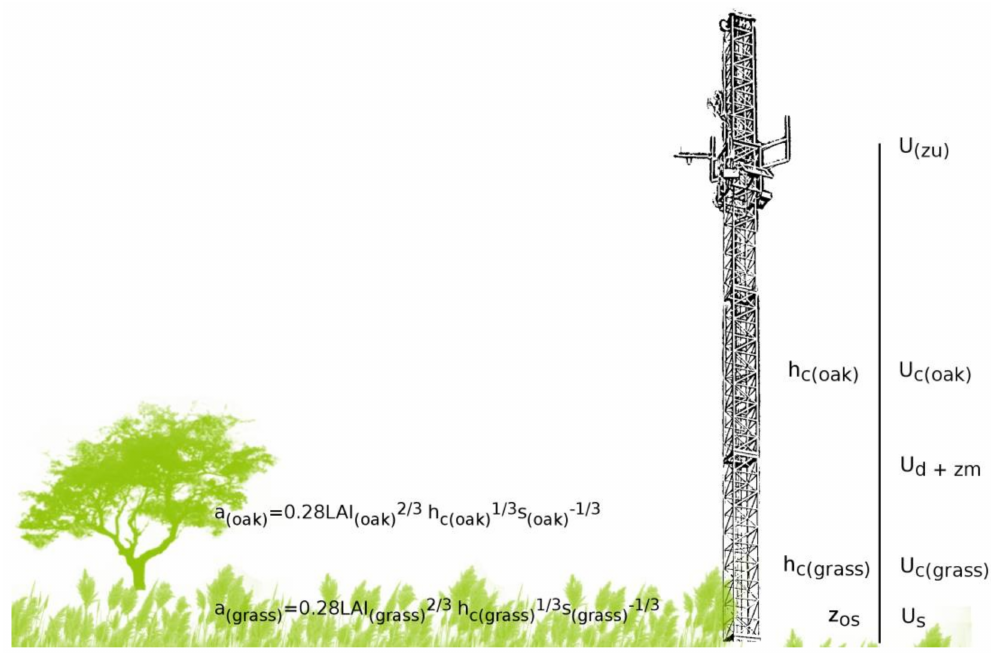
Figure 1. Modified Goudriaan [40] wind-speed profile for the different canopy